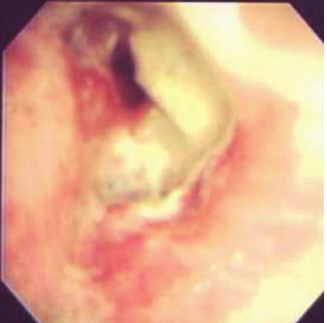
Figure 1 - Endoscopic image of necrosis in the bronchial